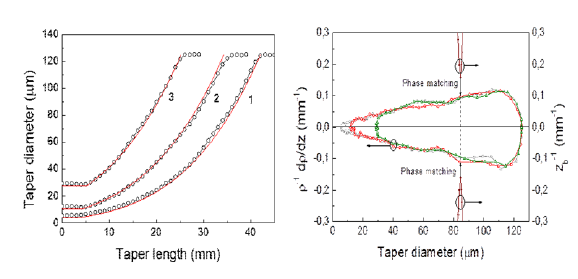
Fig.2. Left: Half taper profiles for three different heat-and-pull processes. Open circles are measured data. The solid lines are fittings to the analytic model, using parameters from Table 1. Right: Adiabatic condition (1/ ρ)dρ/dz < 1/z b where z b is the beat length between HE 11 and HE 12 .